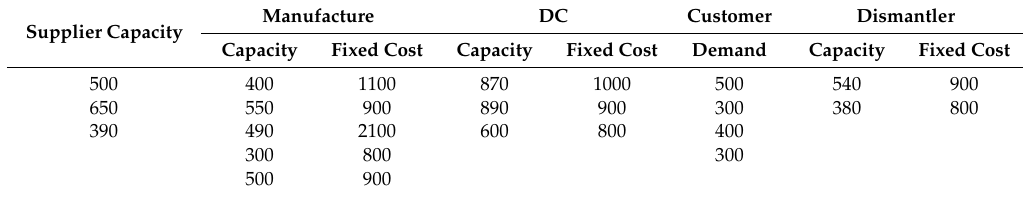
Table 6. Capacity, fixed cost (US$) and demand in Experiment